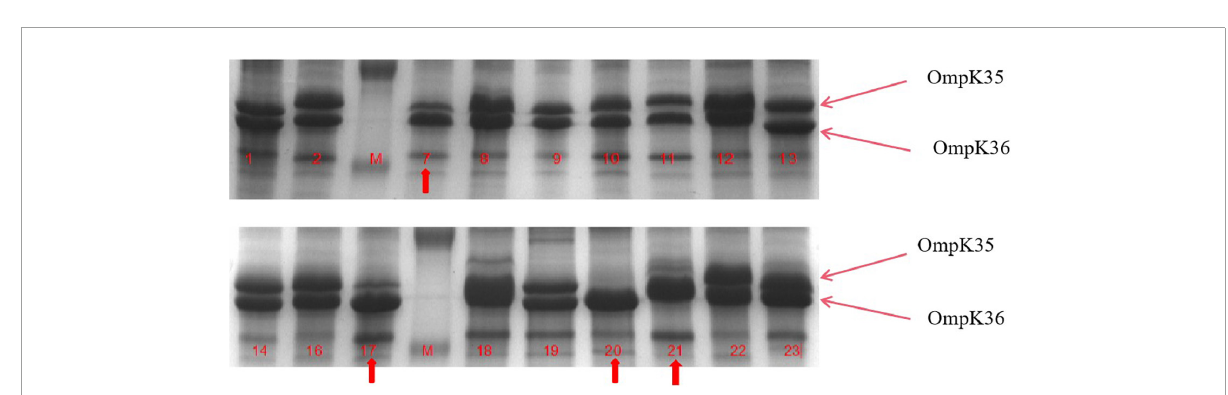
FIGURE2 Outer membrane protein (OMP) profiles of Klebsiella pneumoniae strains on a 12% sodium dodecyl sulphate-polyacrylamide gel. Lanes 1–4 show the OMPs of strains kp7, kp17, kp20, and kp21. Lanes 4–8 show the OMPs of strains kp7, kp17, kp20, and kp21 functionally supplemented with ramR